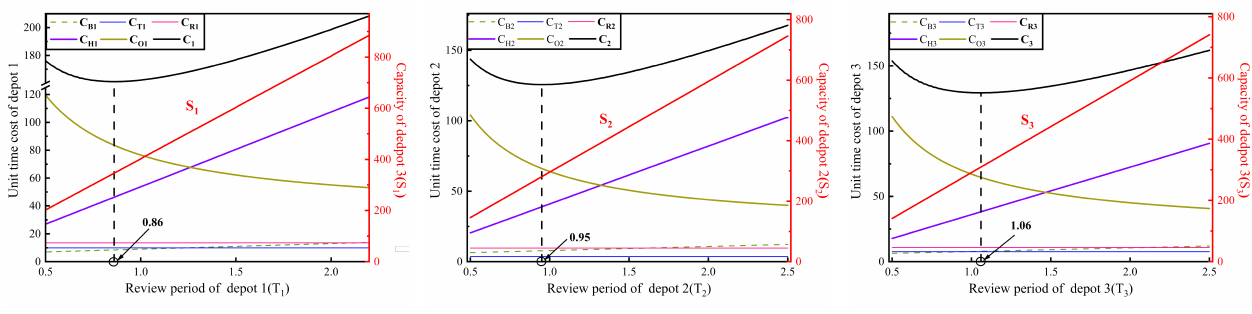
Figure 7. Sensitivity analysis of inventory period. From Figure 7, the red line manifested that the optimal inventory capacity rises linearly with the review period. Simultaneously, with the growth of the review period, the shortage loss (blue line) and the allocation expense (pink line) maintain immutable, whereas the expenditure for inventory (purple line) and maintenance (green line) remain boosting. Nonetheless, since the average per unit time inventory counting cost is proportional to counting frequency 1/ T j , there exists an inversely proportional downward trend to order outlay (yellow line). The aforementioned trends add up to a dip preceding a persistent rise in total cost (the black curve shown). The minimum extreme value is regarded as the final choice of the parameter values marked on the horizontal